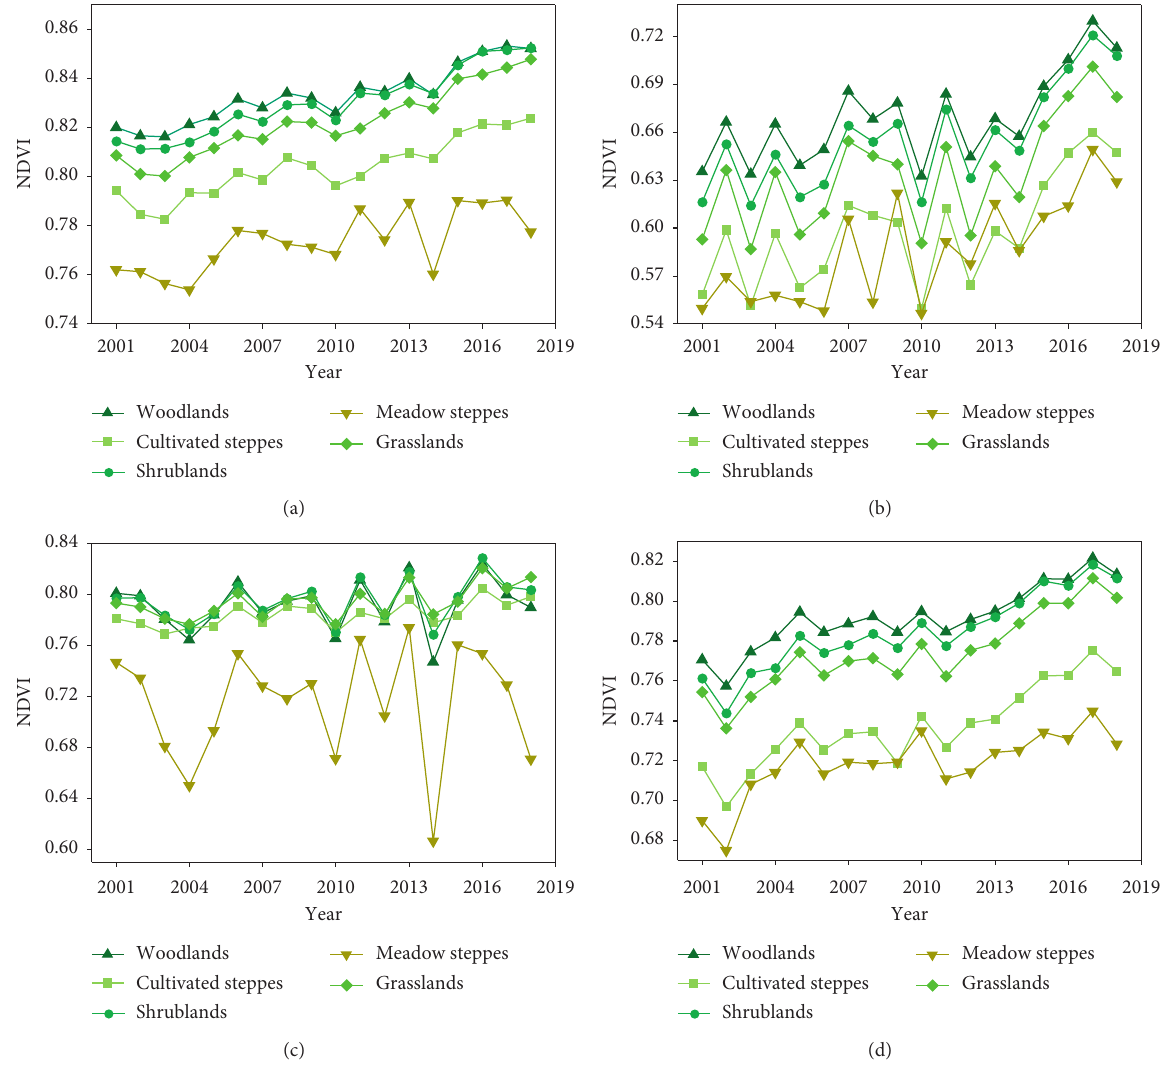
Figure 2: Interannual change of NDVI in different vegetation types in (a) growing season, (b) spring, (c) summer, and (d)